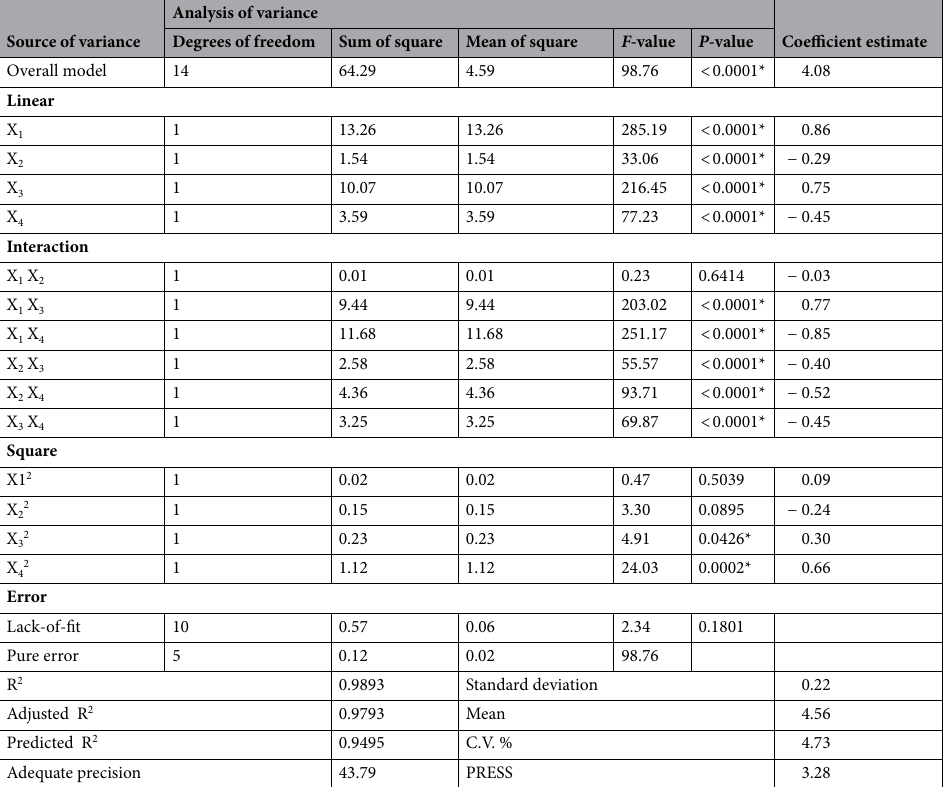
Table 4. Variance analysis and coefficient estimate for the experimental data of chitosan nanoparticles biosynthesis using Streptomyces microflavus strain NEAE-83 obtained by the matrix of CCFCD. *Significant of probability level < 0.05, R 2 : determination coefficient, F : Fisher’s test, C.V: Variation coefficient, PRESS: the prediction error sum of squares, X 1 ; initial pH, X 2 ; chitosan concentration (%), X 3 ; temperature (°C), X 4 ; incubation period (h).